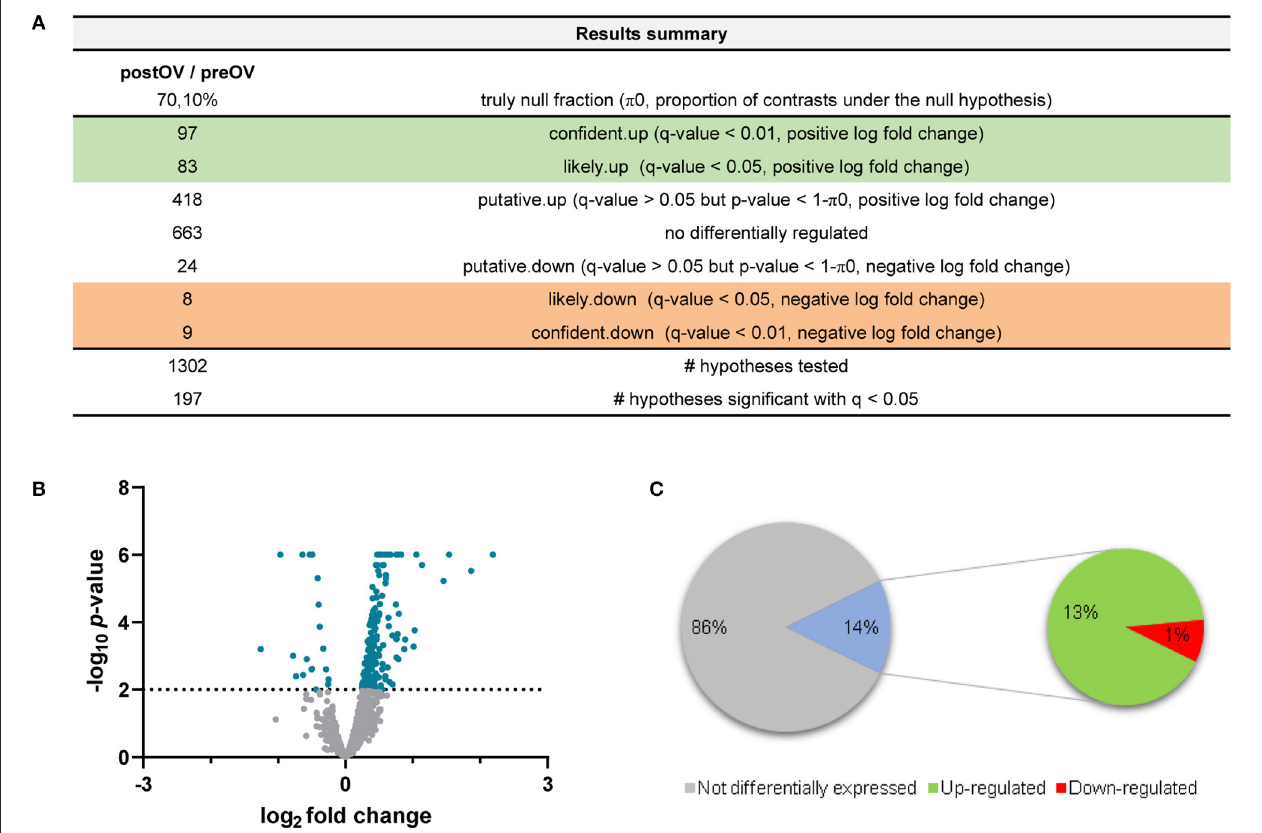
FIGURE 1 | Summary of data analysis for the comparison of post-ovulatory oviductal fluid (post-OF) vs. pre-ovulatory oviductal fluid (pre-OF). (A) The number of expressed proteins (upregulated, downregulated, or non-differentially regulated— left column ) and their degrees of confidence ( right column ) are represented. A total of 1,302 hypotheses were tested. Log2 fold changes and q -values (false discovery rate, FDR) were considered to identify the differentially expressed (upregulated and downregulated) proteins in the post-OF vs. the pre-OF group. (B) Volcano plot representing the differentially and non-differentially expressed proteins. Only proteins with q < 0.05 and –log 10 p > 2 were considered differentially expressed ( blue ). Positive log2 fold changes represent upregulated proteins and negative log2 fold changes represent downregulated proteins. (C) For ease of analysis in Equus caballus databases, repeated, unresolved, and uncharacterized proteins were removed. A total of 1,173 unique, inferred, and characterized proteins (listed in Supplementary Table 1 ) were finally analyzed according to their log2 fold changes and q -values (FDR). Proteins with q -values (FDR) > 0.05 were considered not differentially expressed (1,002 proteins, 86%). Proteins with q < 0.05 were considered differentially expressed (171 proteins, 14%). Positive fold changes represent upregulated proteins (156 proteins, 13%), whereas negative fold changes represent downregulated proteins (15 proteins, 1%). The figures were created with Microsoft Excel and GraphPad